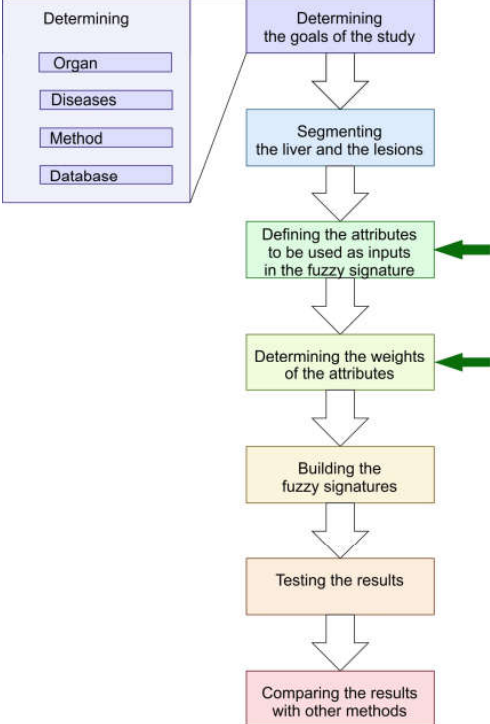
Figure 1. Flowchart of building our fuzzy signature-based decision support method. The green arrows indicate the target area of the present work.